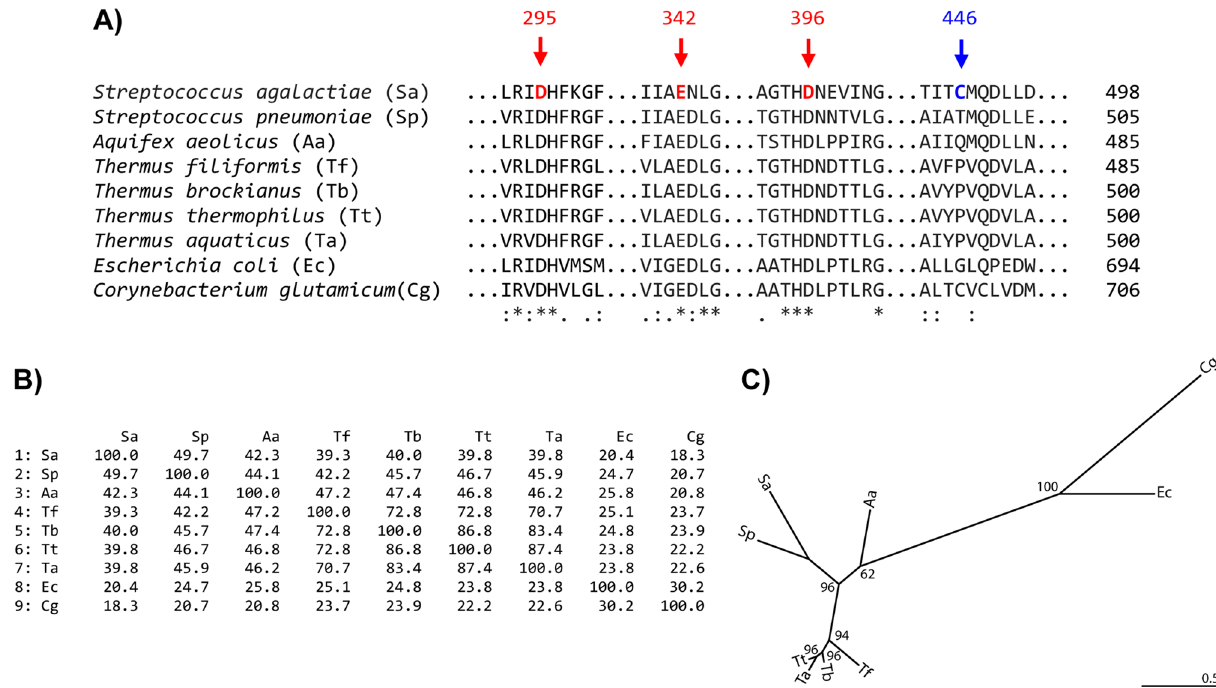
Figure 1. ( A ) Alignment of amino acid sequence of amylomaltases from various bacteria around the regions of interest. Sa; Streptococcus agalactiae (this study), Sp; Streptococcus pneumoniae (WP_00749291), Aa; Aquifex aeolicus (AAC06897), Tf; Thermus filiformis (AKR04336), Tb; Thermus brockianus (2X1I_A), Tt; Thermus thermophilus (YP_144527), Ta; Thermus aquaticus (EED09753), Ec; Escherichia coli (P15977), Cg; Corynebacterium glutamicum (NP_601497). The three catalytic residues are shown in red. C446 of Sa, the residue that was mutated in this study is shown in blue. Amino acid conservation across the aligned sequences is shown as: identical ( asterisk) , conserved substitutions ( colon ) and semi-conserved substitutions ( dot ). The number at the end of each sequence denotes the total amino acid sequence length of each enzyme. ( B ) Amino acid identity matrix. ( C ) Unrooted phylogenetic created by IQ-TREE with bootstrap values at the nodes. Length scale is shown at the bottom-right corner. Total protein Total activity Specific activity Purification step